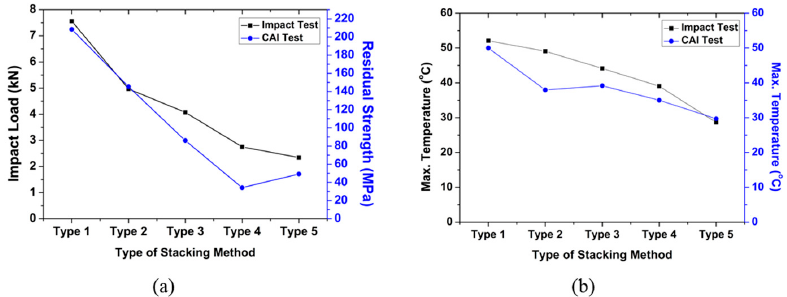
Figure 11. Comparison of the test results: ( a ) compression residual strength and impact load of each type, and ( b ) compression residual strength and temperature of each type.